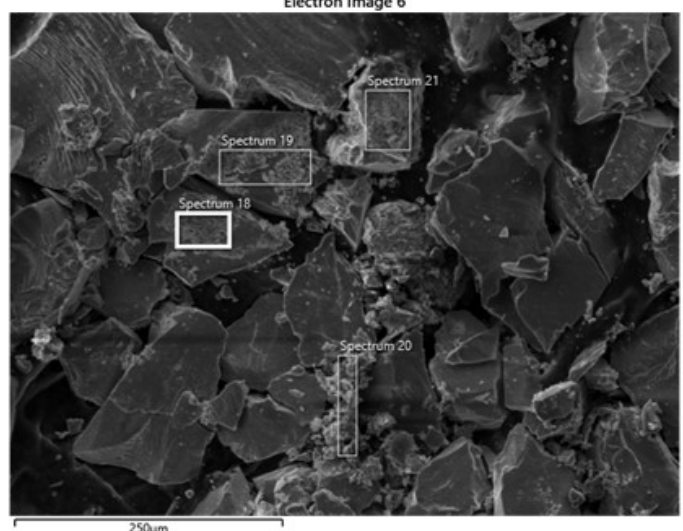
Figure 6. SEM micrographs of chalcopyrite collected as concentrated in the froth phase. The flotation